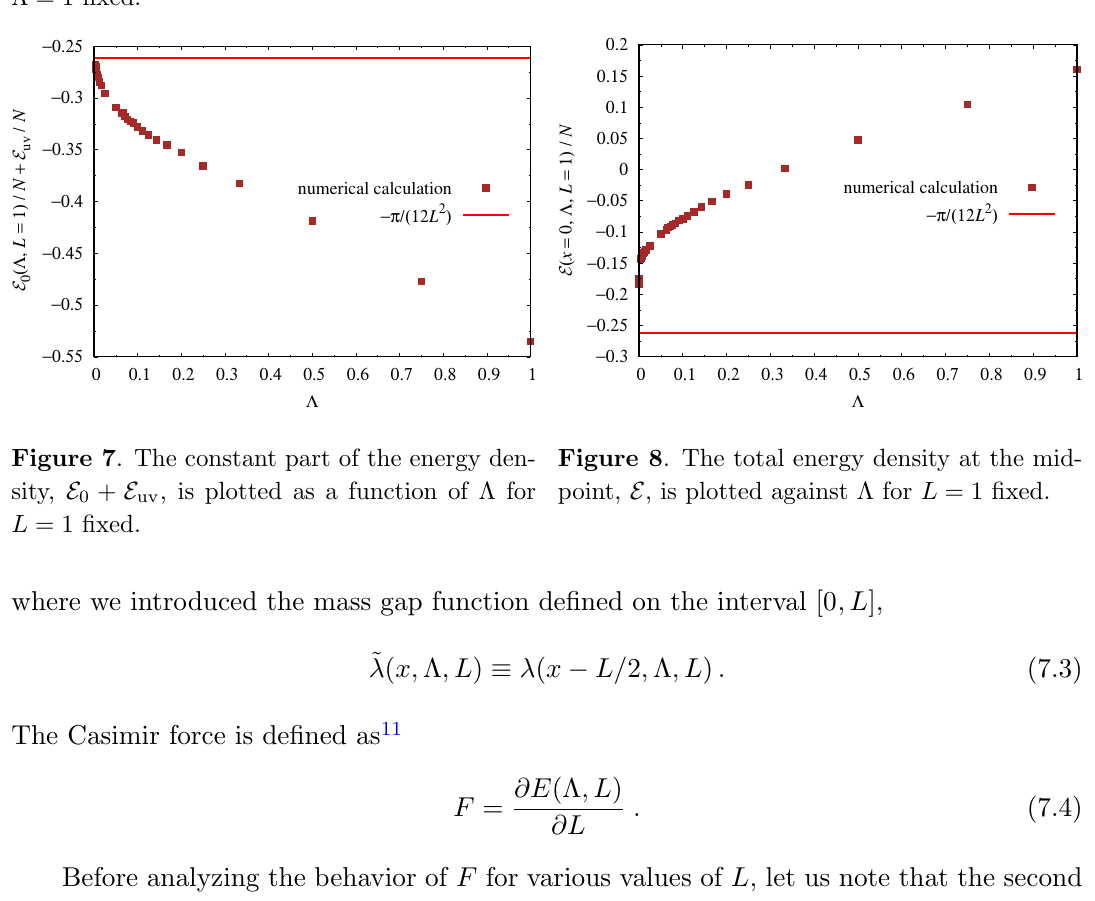
Figure 5 . The constant part of the energy den- sity, E 0 + E uv , is plotted as a function of L for (cid:3) = 1 (cid:12)xed.